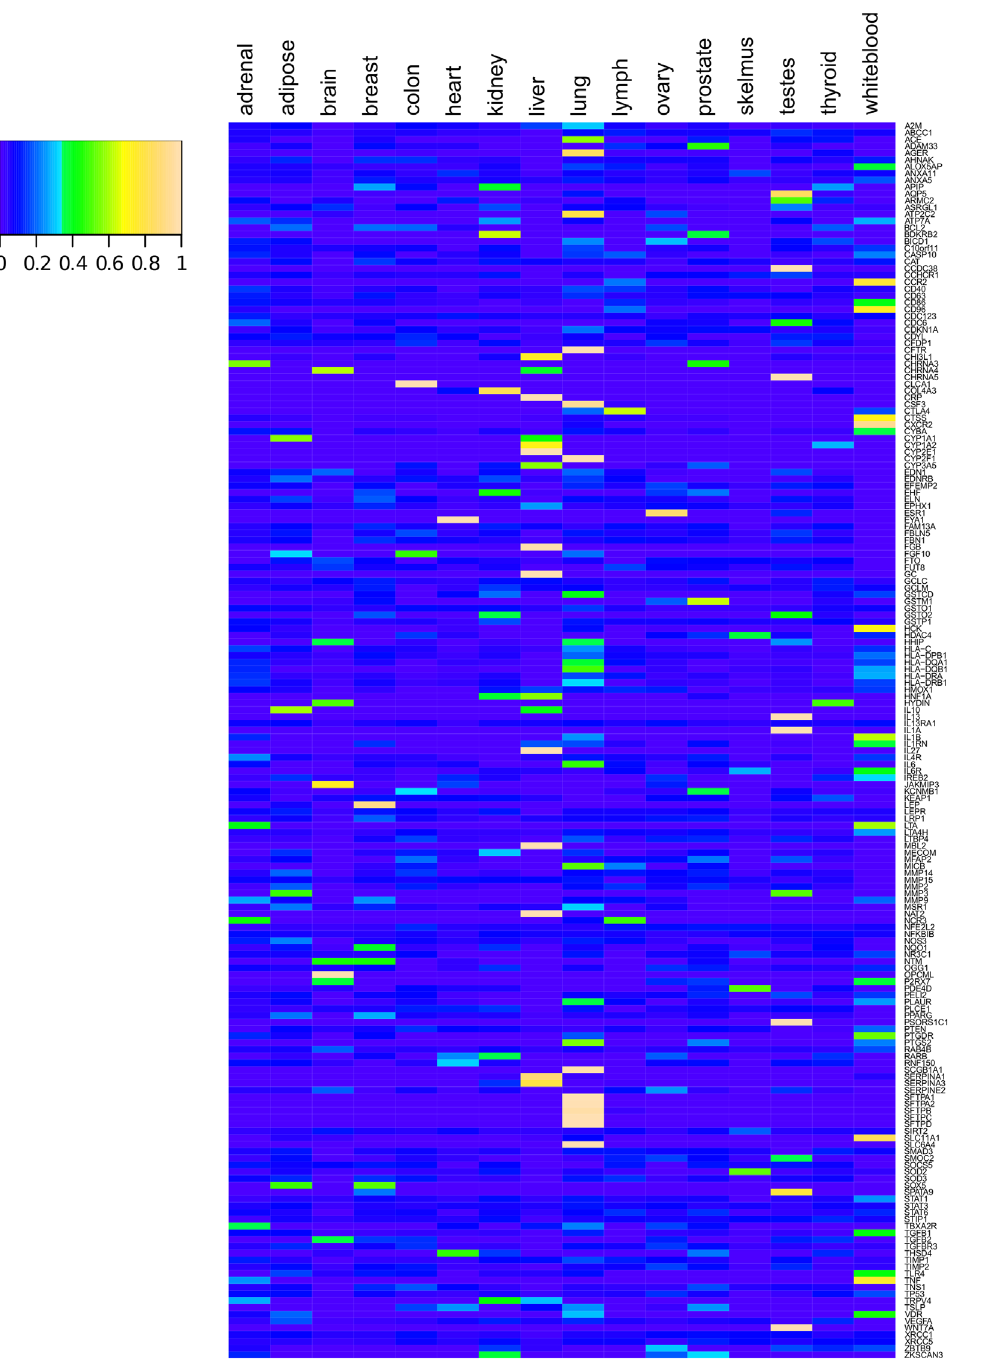
Fig 6. Highly expressed COPD-associated gene transcripts are enriched in lung tissue. The highest expressed transcript from each COPD-associated gene is shown as a percentage of expression in each of the 16 tissues from BodyMap. COPD-associated gene expression is highest in lung, white blood cells, testes and liver (14.5%, 9.9%, 9.0% and 8.7%), respectively. Other COPD-associated transcripts not in these tissues are still tissue specific and may be detrimental if expressed in the lung. Splice variants were determined as alternative splice sites through ASprofile